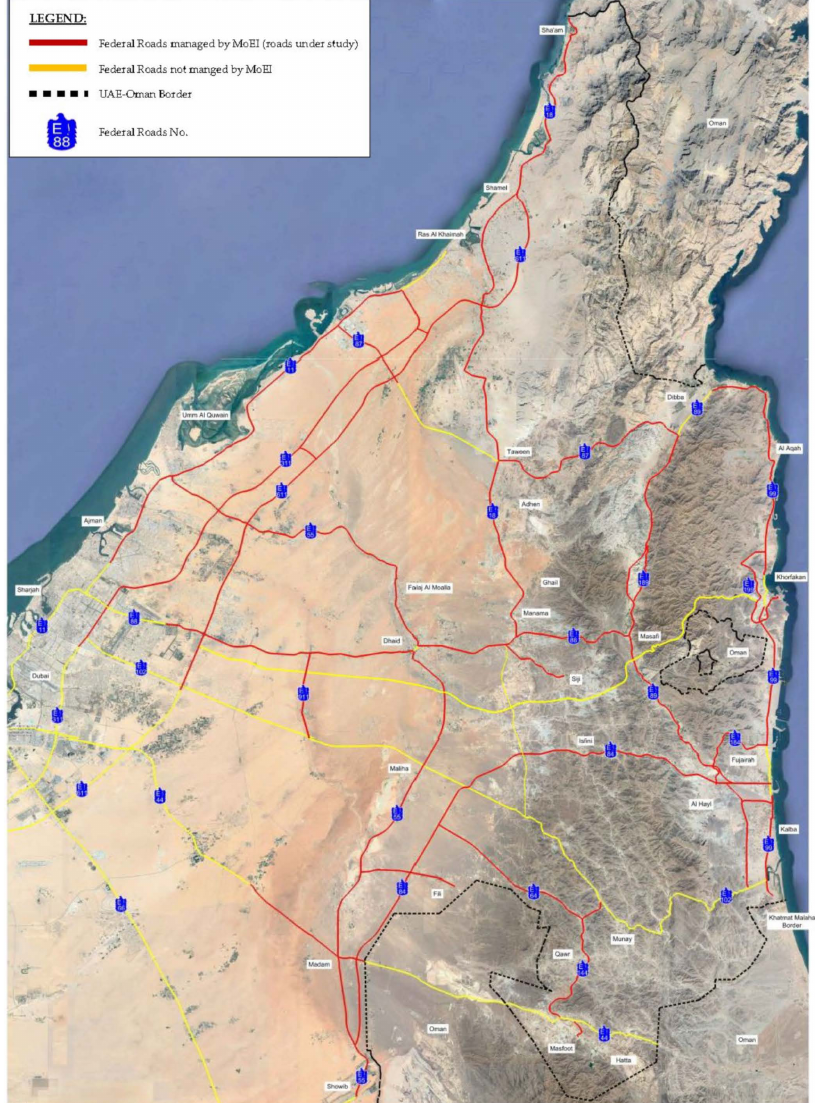
Figure 4. Selected road networks (red lines) for